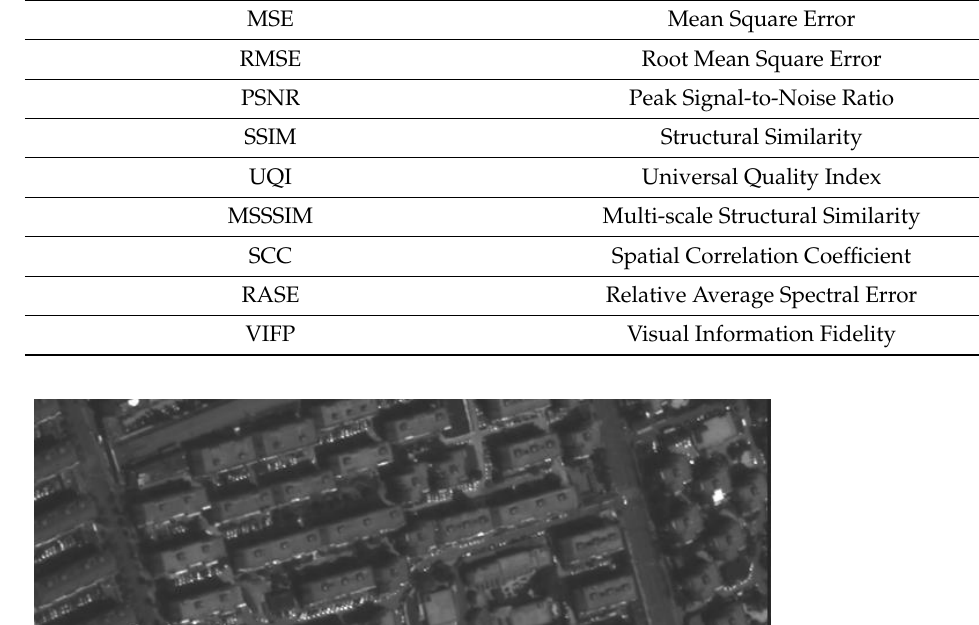
Figure 18. The original image of buildings. Table 4. The compression indices’ comparison with different compression rates.